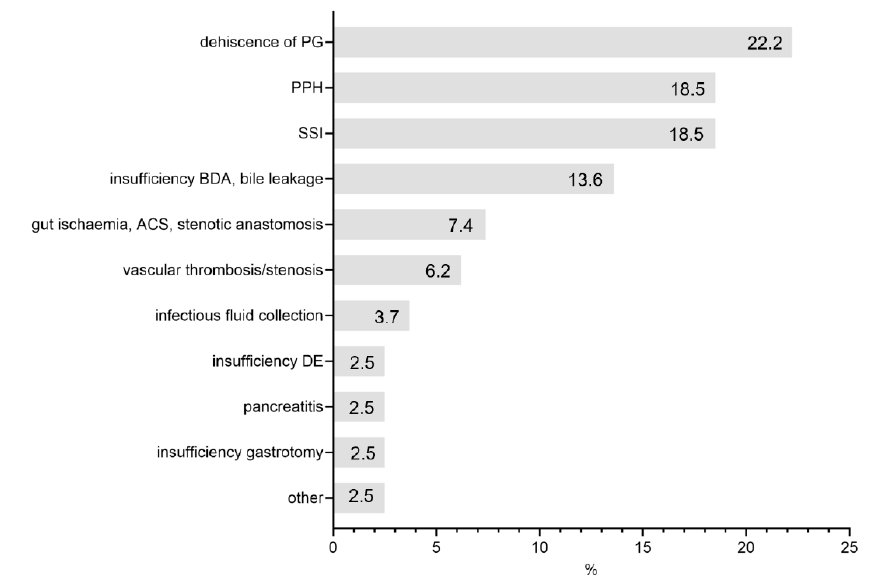
Figure 2. Indications for reoperation.